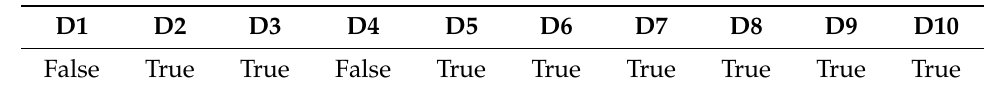
Figure 5. ( a ) Feature importance values in descending order, from left to right. ( b ) Schematic diagram of optimal feature subset selection. Table 7. Selected features